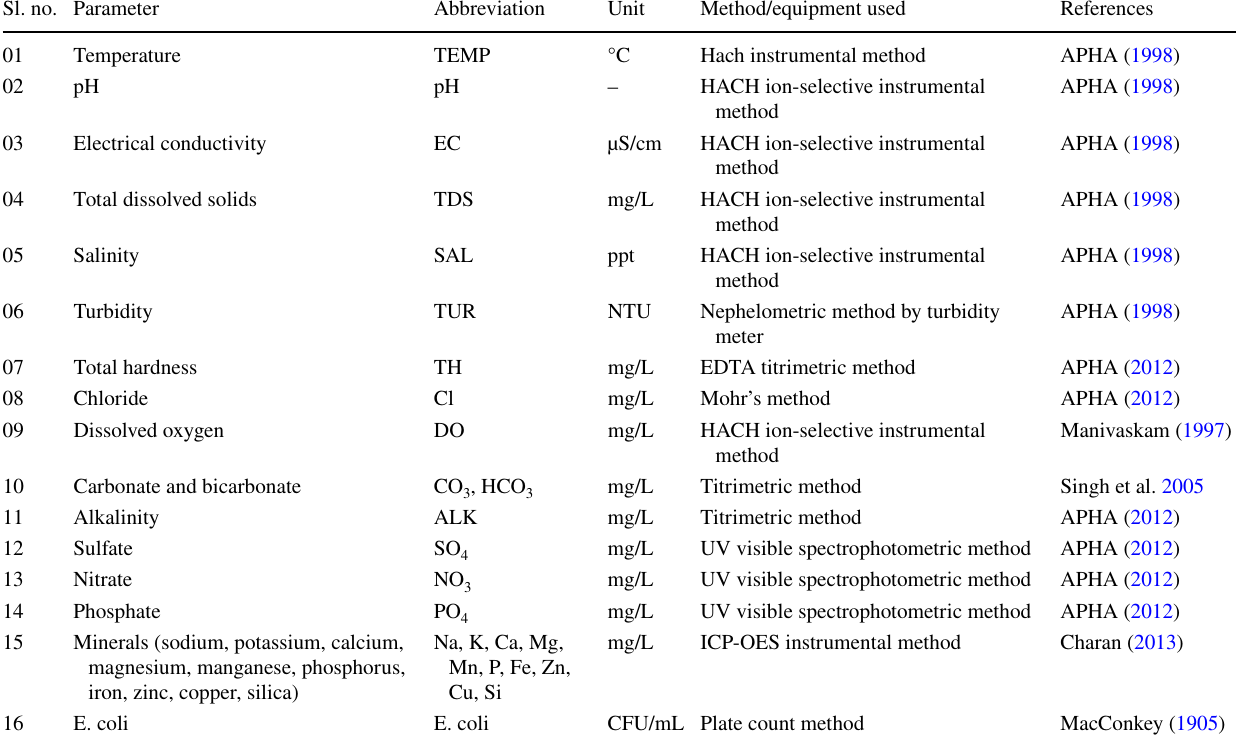
Table 1 Physicochemical parameters determined and analytical techniques used Sl. no. Parameter